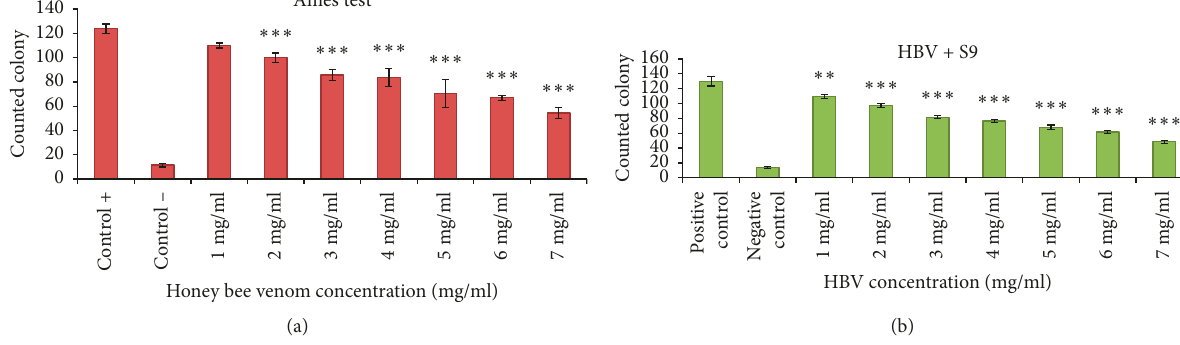
Figure 3: Reverted Salmonella TA100 colonies counts in compression with a positive control group with (a) and without S9 (b) by the Ames test (mean ± SEM, ∗∗∗ p < 0 . 001, ∗∗ p < 0 . 01).